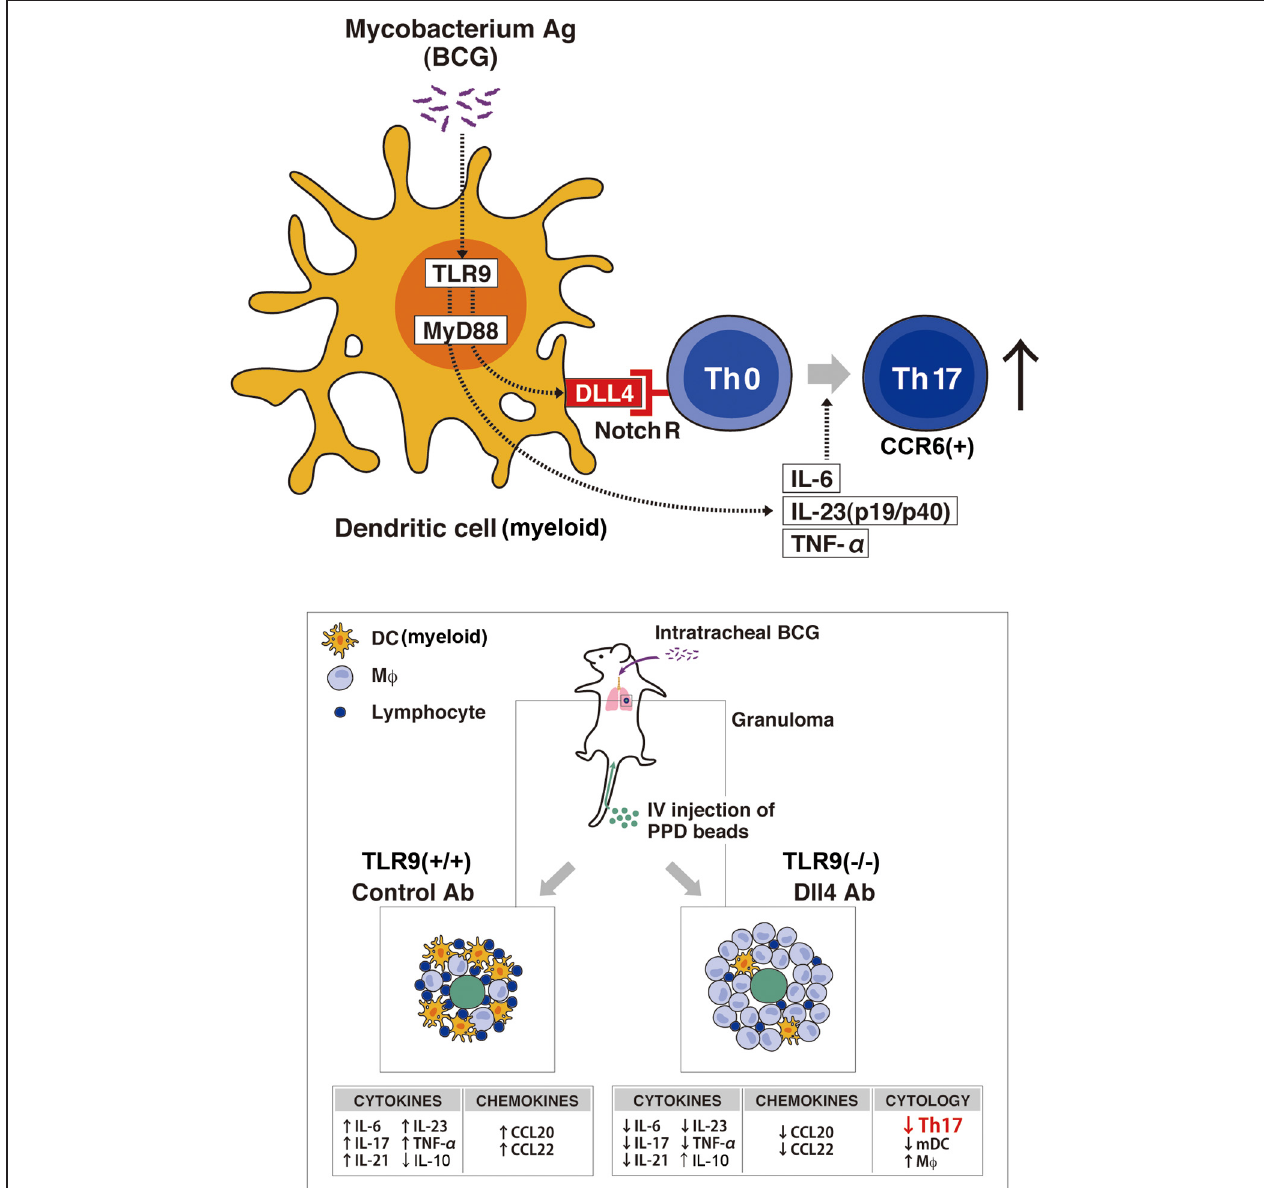
FIGURE 2 | Schematic representation of the TLR9-Notch ligand (dll4) on Mycobacterium -dependent granuloma formation. Myeloid DCs (mDCs) play an important role in inducing the differentiation of Th17 cells through the TLR9 effector pathway that upregulates the Notch ligand dll4. In vivo granuloma formation induced by BCG/ Mycobacterium Ag demonstrates larger granuloma formation in TLR9-knockout mice (TLR9 − / − ) with decreased numbers of Th17 cells (CCR6 + ) and mDCs in the lungs when compared with lung granulomas from WT mice. Further, TLR9 − / − mice showed an increase in IL-10 with a concomitant decrease